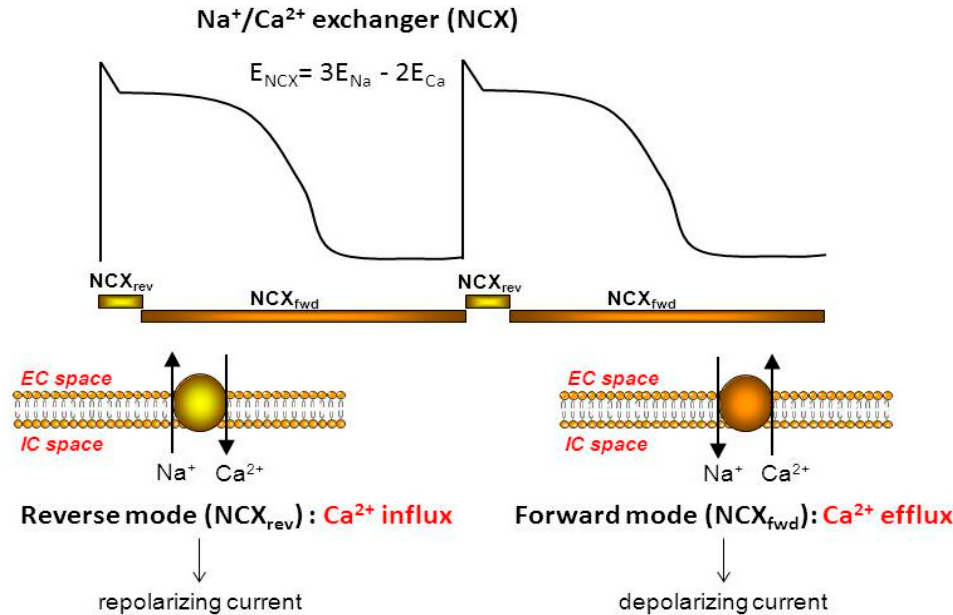
Figure 2. Schematic illustration of the presumed NCX function during ventricular action potential. The reverse mode of the NCX (Ca 2+ influx/outward current) is restricted to the beginning of the action potential. The forward mode (Ca 2+ efflux/inward current) is suggested to be active during the latter part of the plateau.